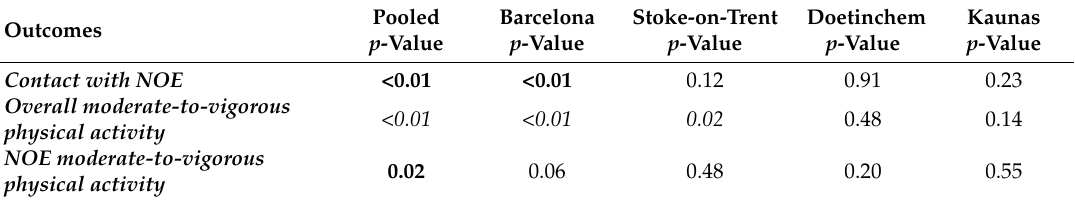
Table A3. Comparison of outcomes between weekdays and weekends. T-student tests